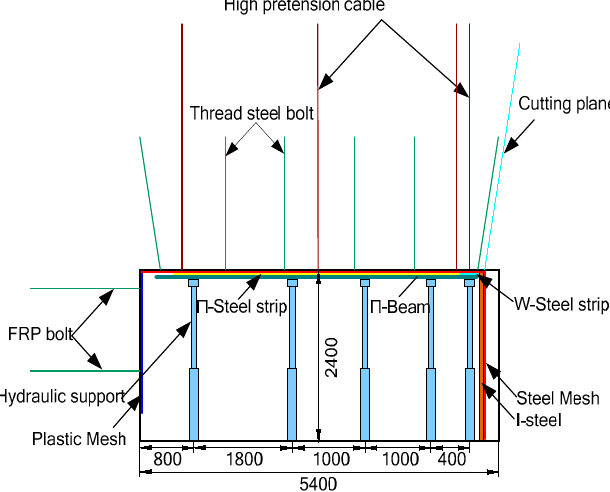
Figure 10. Support scheme of the gob-side entry.